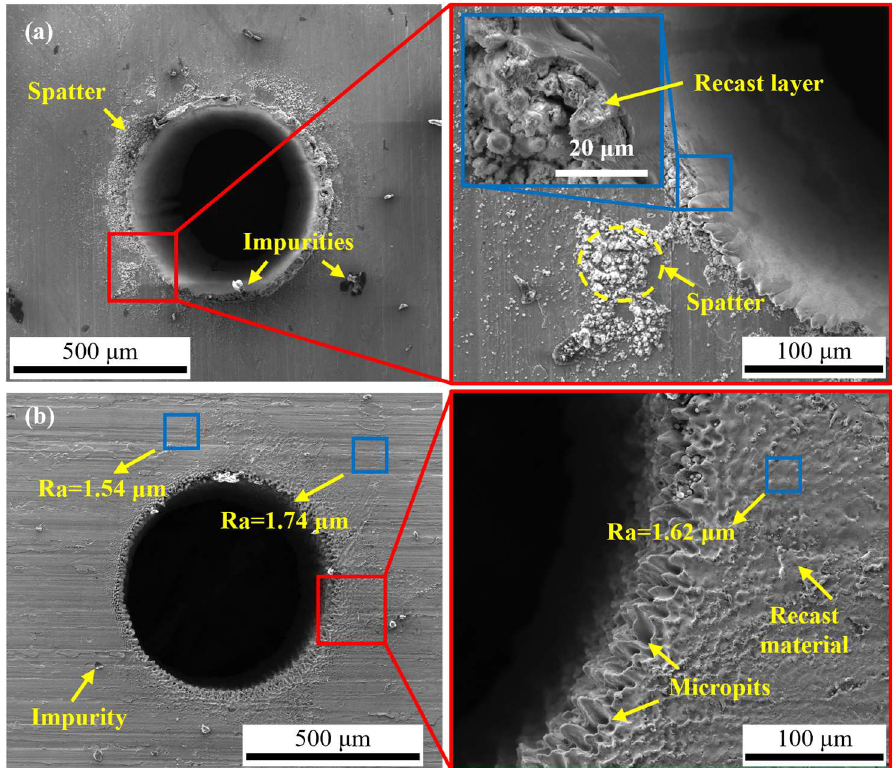
Figure 15. SEM morphologies of the hole entrance by laser machining in different conditions. ( a ) Laser machining in the air; ( b ) CWALSM.